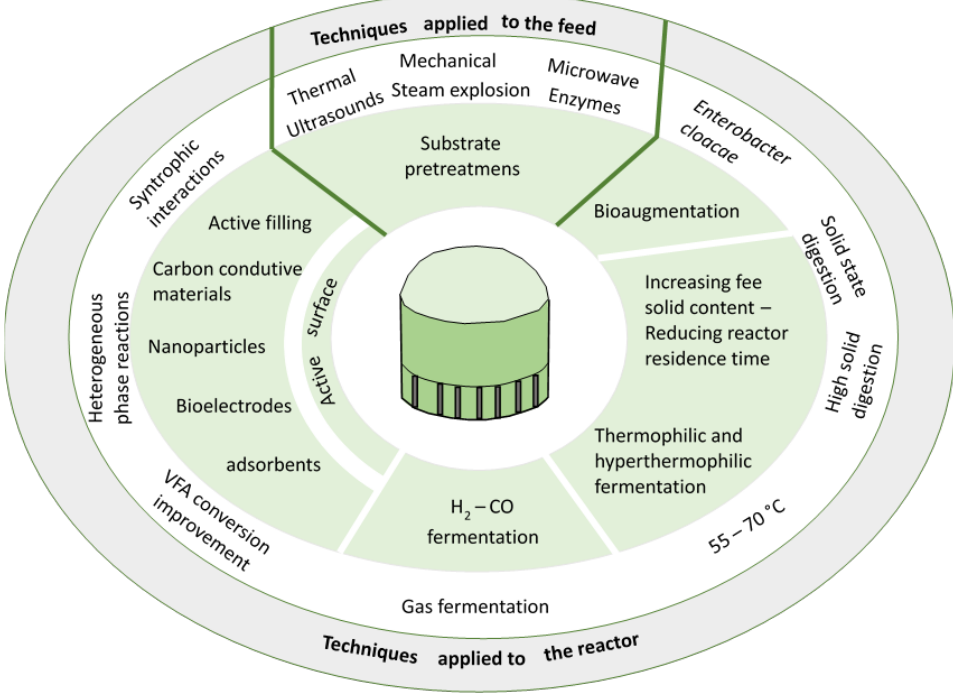
Figure 3. Techniques for improving anaerobic digestion performance.